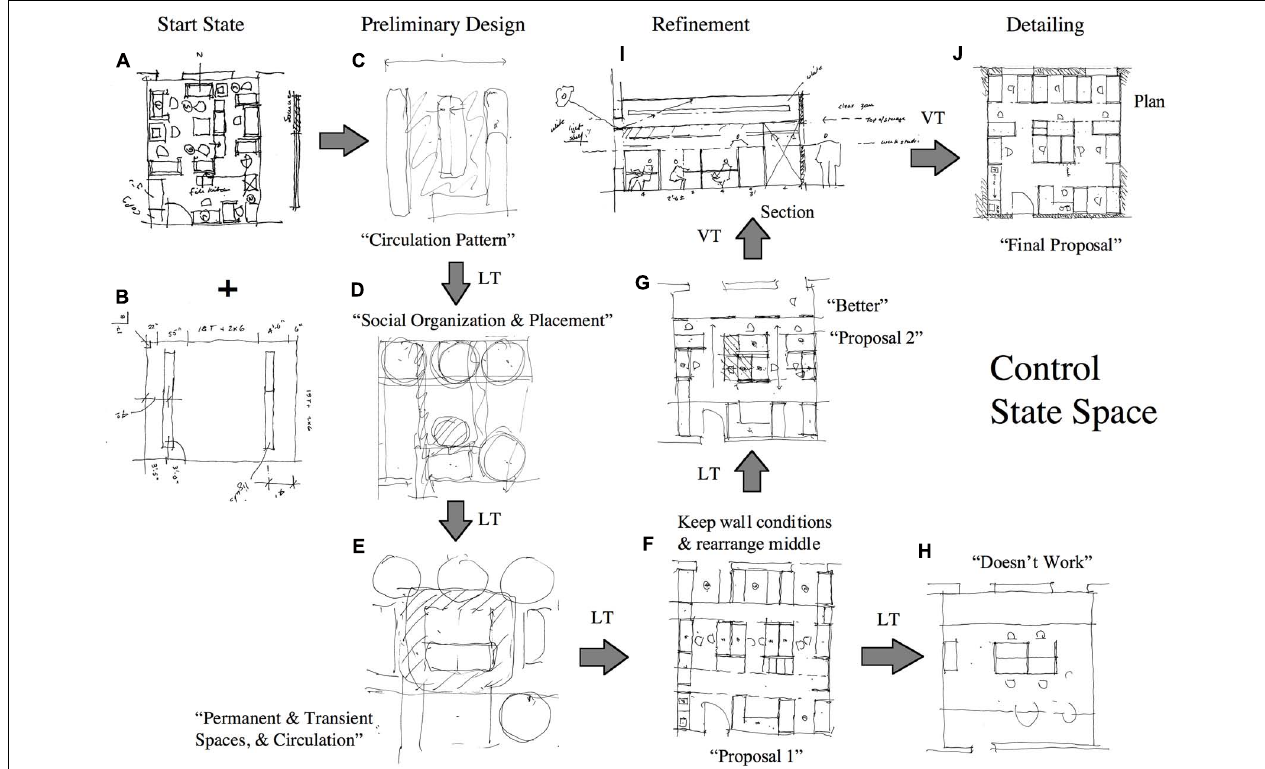
FIGURE 6 | Control subject’s state space and transformation functions. Drawings A and B constitute the problem start state.The drawings I and J constitute the final (goal) state. Drawings C through G constitute the intermediate states. LT indicates a lateral transformation.VT indicates a vertical transformation. See